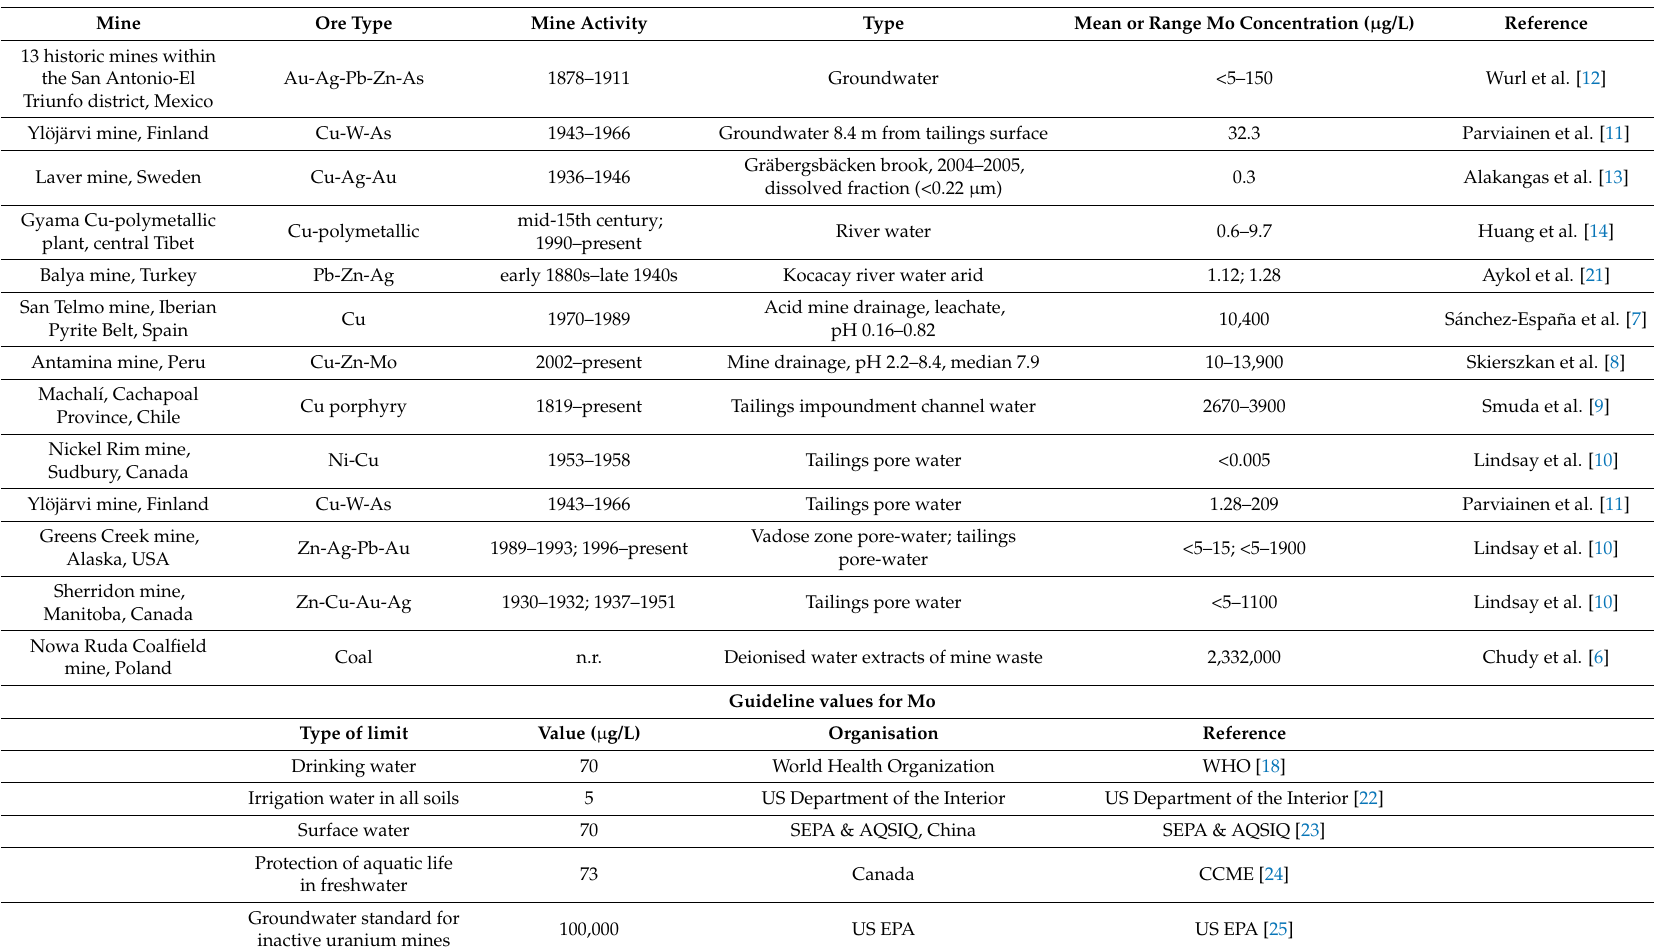
Table 1. Concentrations of Mo in mining-affected